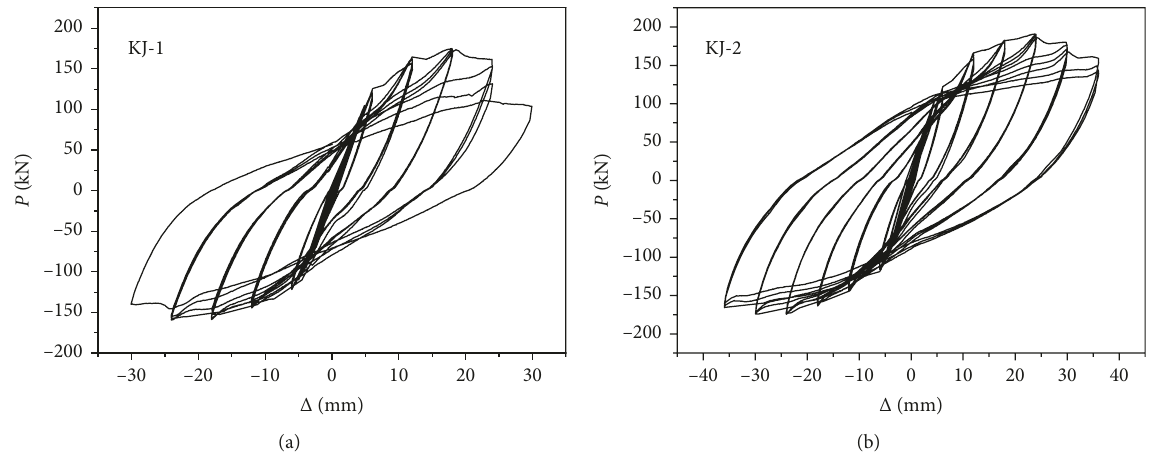
Figure 6: Hysteresis curves for specimens: (a) specimen KJ-1, (b) specimen